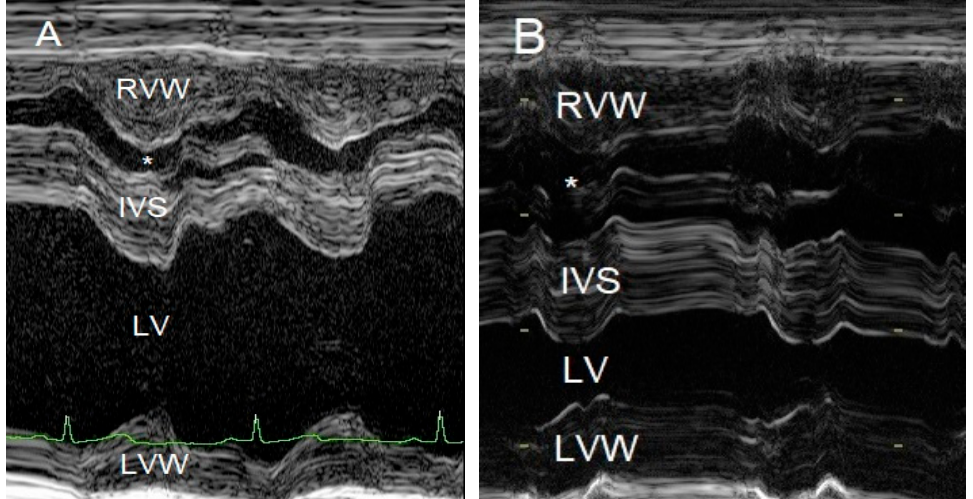
Figure 4. M-mode echocardiographic images of the right and left ventricles at 10 weeks of age ( A ) and 3 years of age ( B ). The most striking difference is the reduced left ventricular chamber (LV) size from normal to too small and the enlargement of the right ventricular chamber (*) caused by a mixed concentric and eccentric hypertrophy. The left ventricular diastolic chamber dimension at 10 weeks of age was 18.7 mm, and this value became 9.9 mm at 3 years of age. Annotations are placed on structures in systole: RVW—right ventricular free wall; IVS—interventricular septum; LVW—left ventricular free wall.